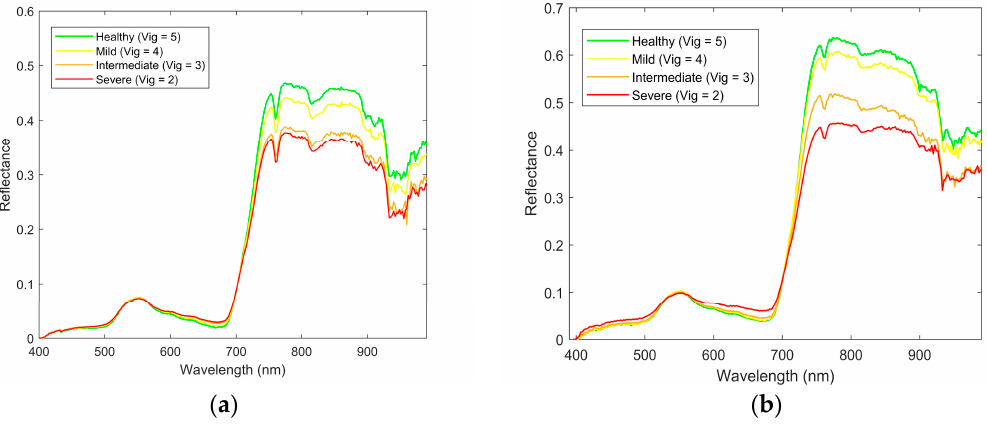
Figure 13. Mean spectral signature for different levels of vigour of the grapevine for the V. vinifera Chardonnay variety measured in ( a ) December 2016, and ( b ) February 2017 for wavelengths from 400 to 1000 nm.